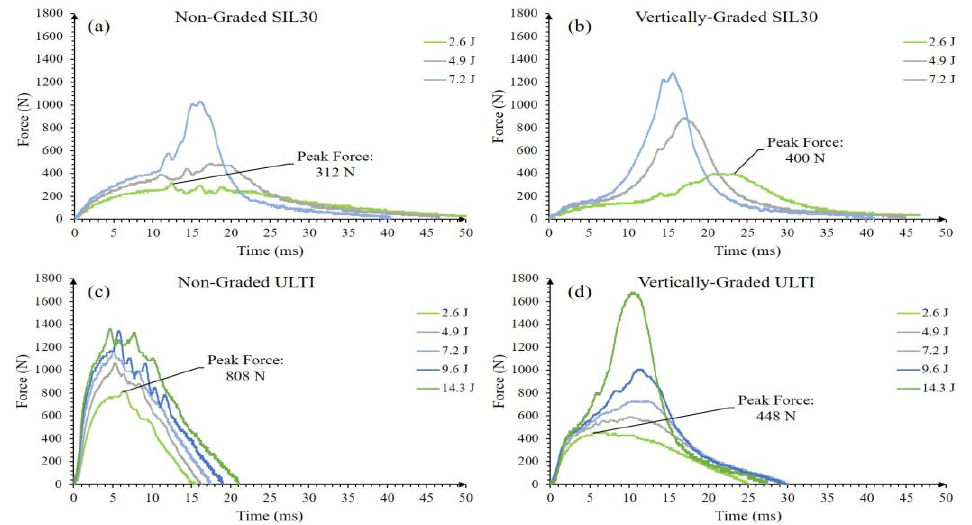
Figure 4. Force versus time of SIL30 and ULTI at different impact energies; ( a ) SIL30-NG (non- graded), ( b ) SIL30-VG (vertically-graded), ( c ) ULTI-NG, and ( d ) ULTI-VG with peak force values labeled for comparison.